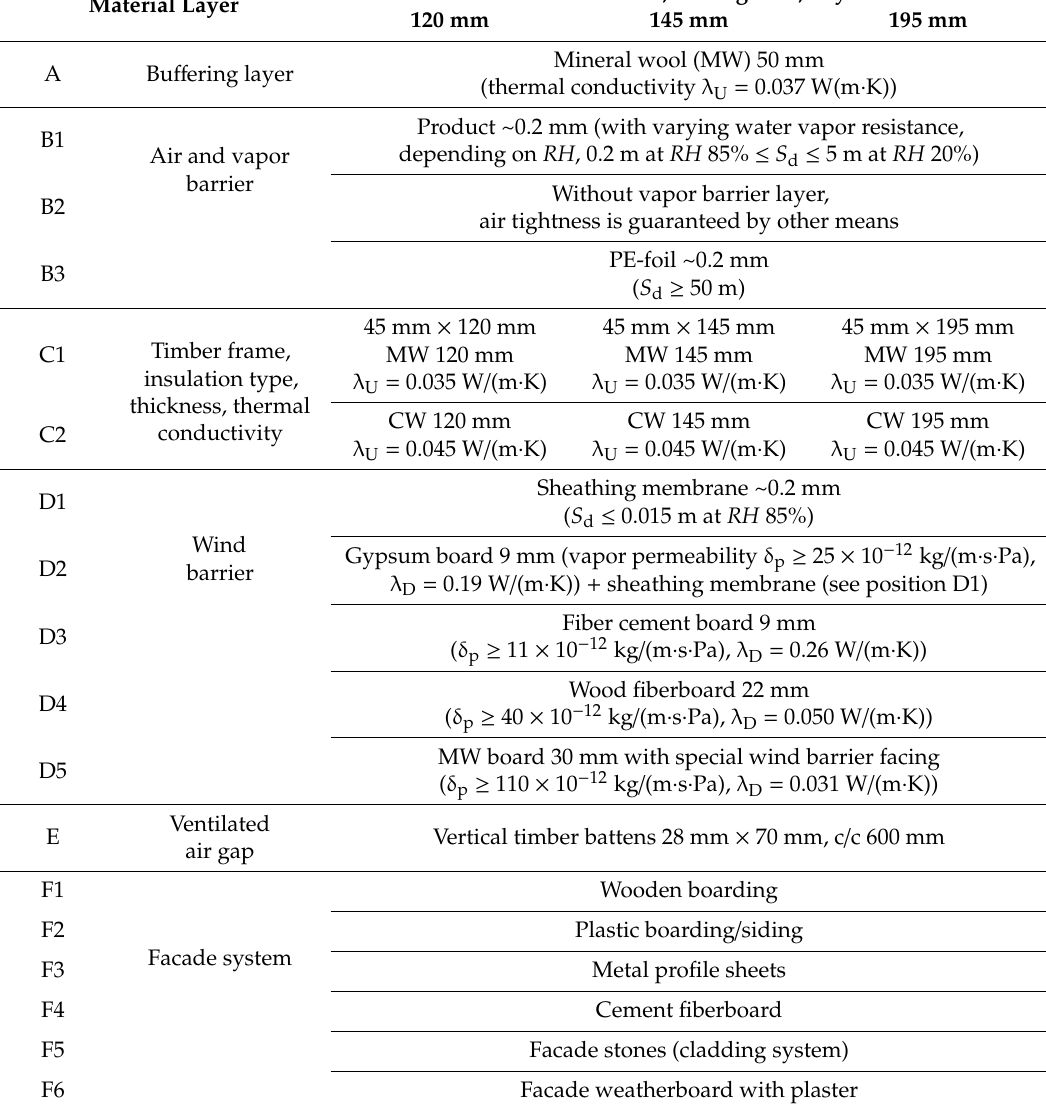
Table 1. Description of materials (see Figure 1) in sets of analyzed structures.